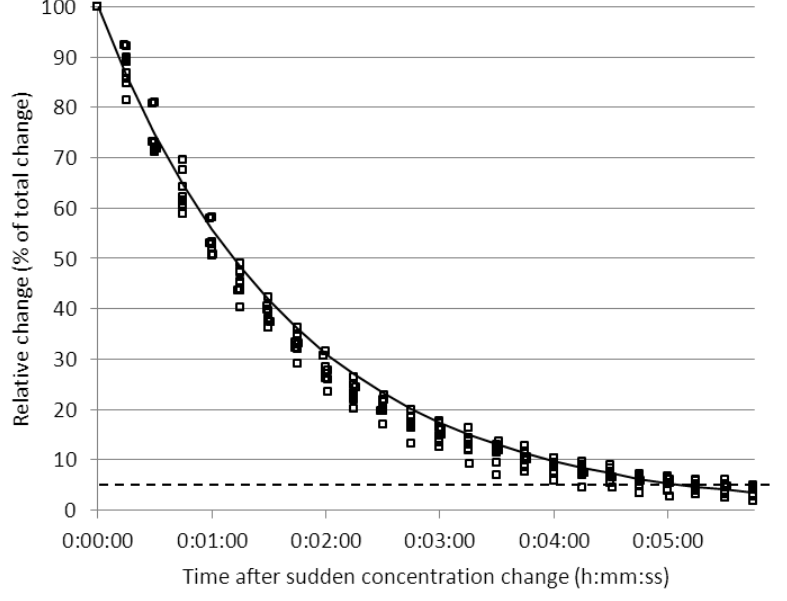
Figure 9. Sensor time response, expressed in relative terms: 100% represents the initial concentration and 0% the final